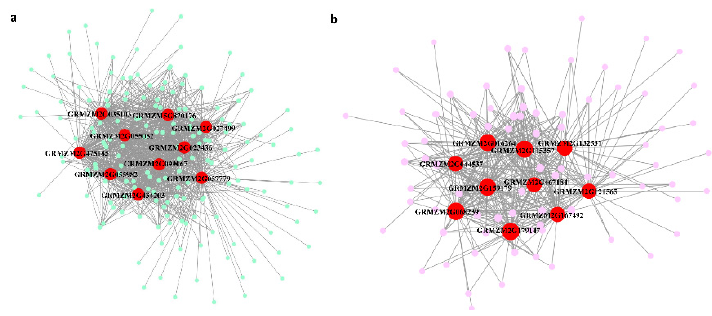
Figure 8. Co-expression network of related gene modules grey60 ( a ) and purple ( b ). Only hub genes from two modules were exhibited in the network.